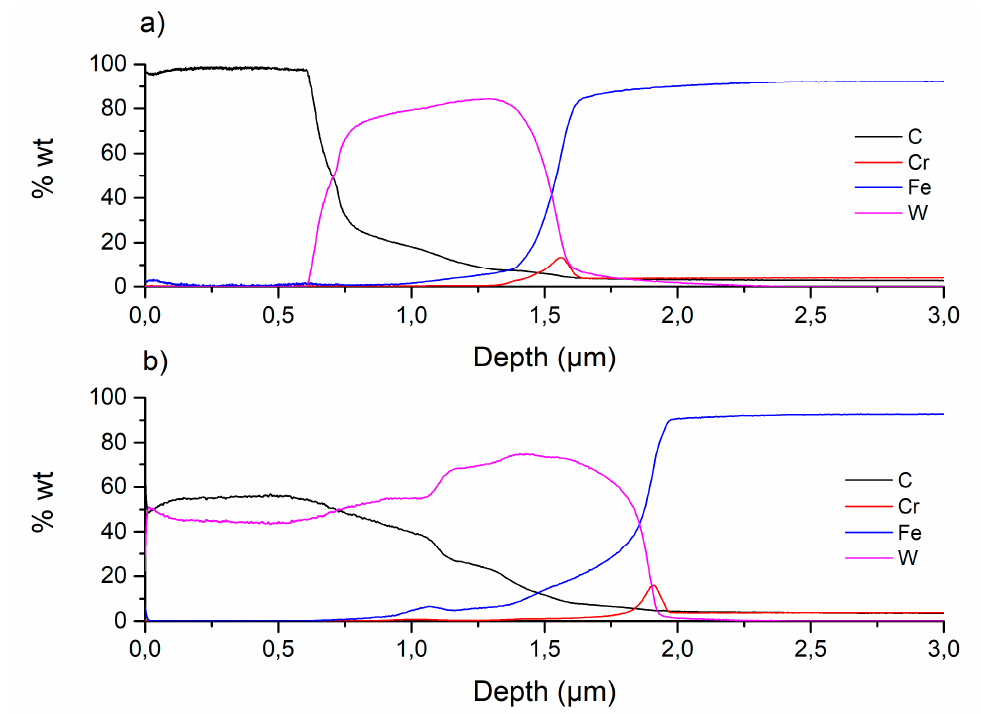
Figure 3. Glow discharge optical emission spectrometry (GD-OES) concentration profiles in the sample of ta-C coating ( a ) and WC:C coating ( b ).